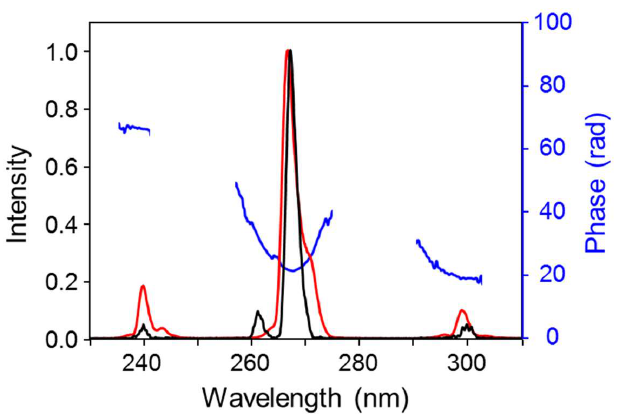
Figure 2. Emission spectrum for the Raman sidebands. Red, observed data; black, retrieved spectrum; blue, retrieved